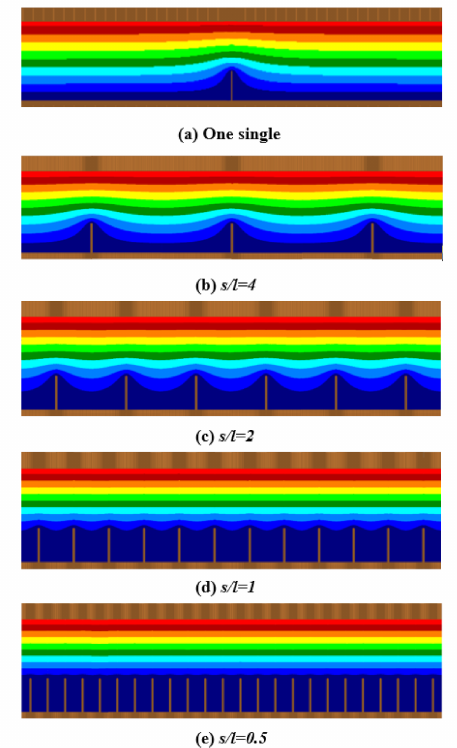
Figure 4. The potential distribution of graphite sheet arrays with a thickness of 40 nm at field emission ( a ): single root, ( b ): s / l = 4, ( c ): s / l = 2, ( d ): s / l = 1, and ( e ): s / l = 0.5.